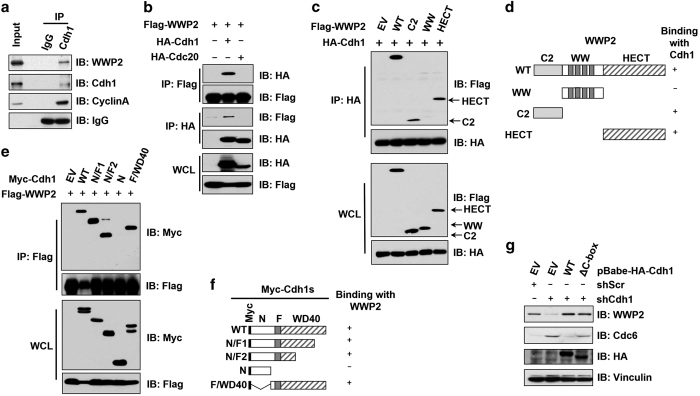
WWP2 interacted with Cdh1 through its C2 and HECT domains. (a) Immunoblot (IB) analysis of whole-cell lysates (WCL) and anti-Cdh1 immunoprecipitates (IP) derived from 293 T cells. Mouse IgG was used as a negative control for the IP procedure. (b) IB analysis of WCL and IP derived from 293 T cells transfected with HA-Cdh1 or HA-Cdc20 and Flag-WWP2 constructs. Thirty-six hours post transfection, the cells were pretreated with 10 μM MG132 for 10 h before collecting. (c) IB analysis of WCL and IP derived from 293 T cells transfected with HA-Cdh1 and the indicated Flag-WWP2 constructs. Thirty-six hours post transfection, the cells were pretreated with 10 μM MG132 for 10 h before collecting. (d) A schematic illustration of the WWP2 truncation mutants used in c. (e) IB analysis of WCL and IP derived from 293 T cells transfected with Flag-WWP2 and the indicated Myc-Cdh1 constructs. Thirty-six hours post transfection, the cells were pretreated with 10 μM MG132 for 10 h before collecting. (f) A schematic illustration of the Cdh1 truncation mutants used in e. (g) IB analysis of MDA-MB-231 cells infected with the indicated lentiviral shRNA constructs together with the indicated pBabe-HA-Cdh1 retroviral constructs. The infected cells were selected with 1 μg ml−1 puromycin and 200 μg ml−1 hygromycin for 72 h to eliminate the noninfected cells before collecting for IB analysis. shRNA, short hairpin RNA.